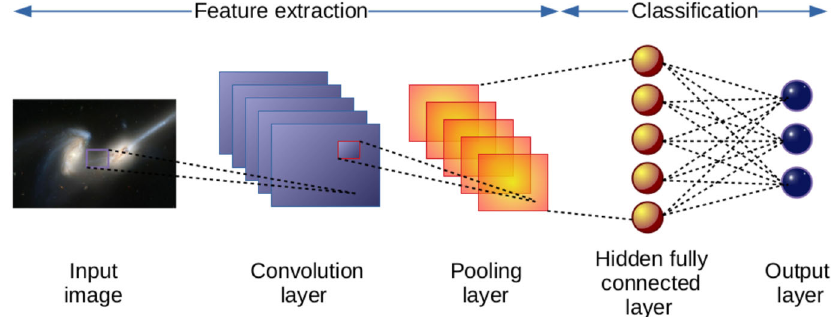
Fig. 28 Schematic representation of a basic convolutional neural network architecture. Such numerical network can be trained on simulations, and later apply to observations to systematically identify MBHB candidates. Image credit: Ioana